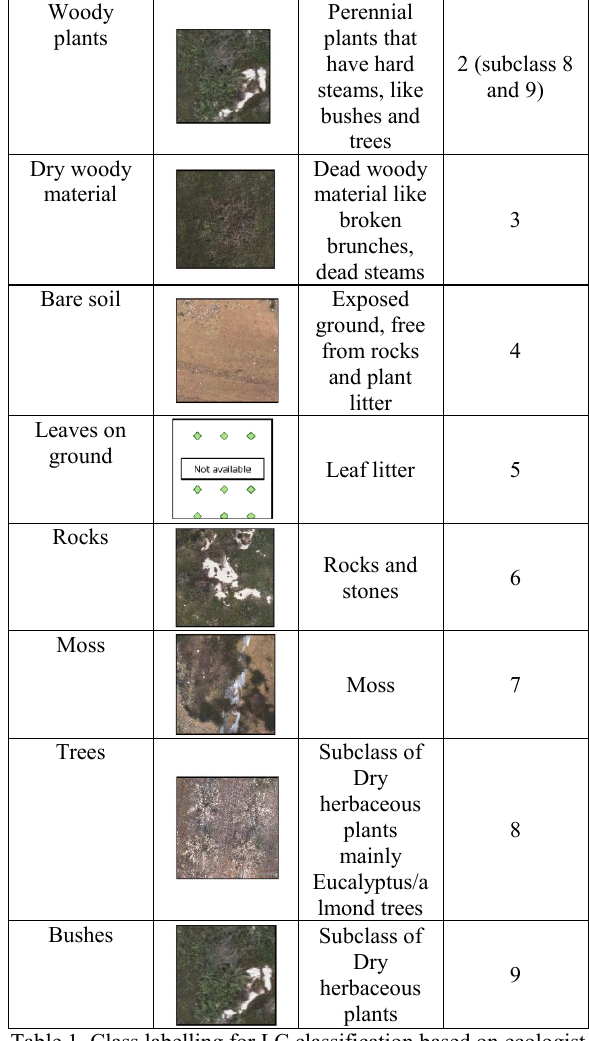
Table 1. Class labelling for LC classification based on ecologist expert directives.